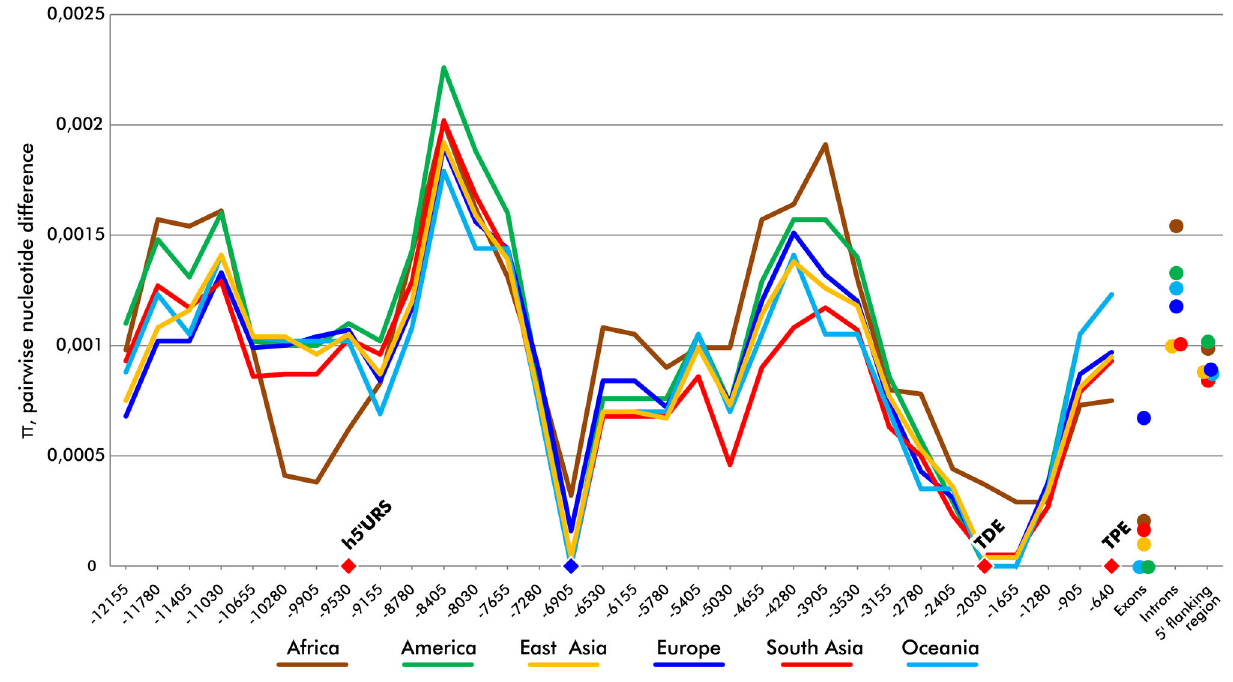
Figure 1. Sliding window analysis of pairwise nucleotide differences in the 5’ flanking region of the TYR gene. Average estimates of pairwise differences (π) at exons, introns and the complete 5’ flanking region are provided for reference. Pairwise differences in six regional population groups are shown separately. Approximate locations of previously known regulatory elements (TDE, TPE and h5’URS) are marked with red diamonds. A newly identified region with decreased genetic variability is marked with a blue diamond. Position numbers are shown relative to the first codon of the TYR gene. Sliding window size is 1500 bp and step size is 375